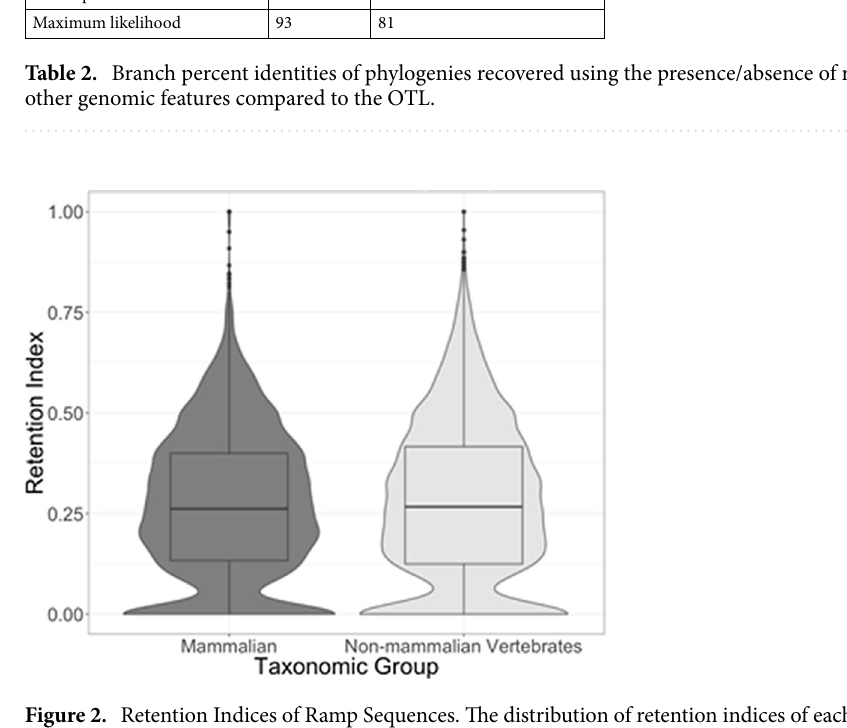
Figure 2. Retention Indices of Ramp Sequences. The distribution of retention indices of each ramp sequence in non-mammalian vertebrates and